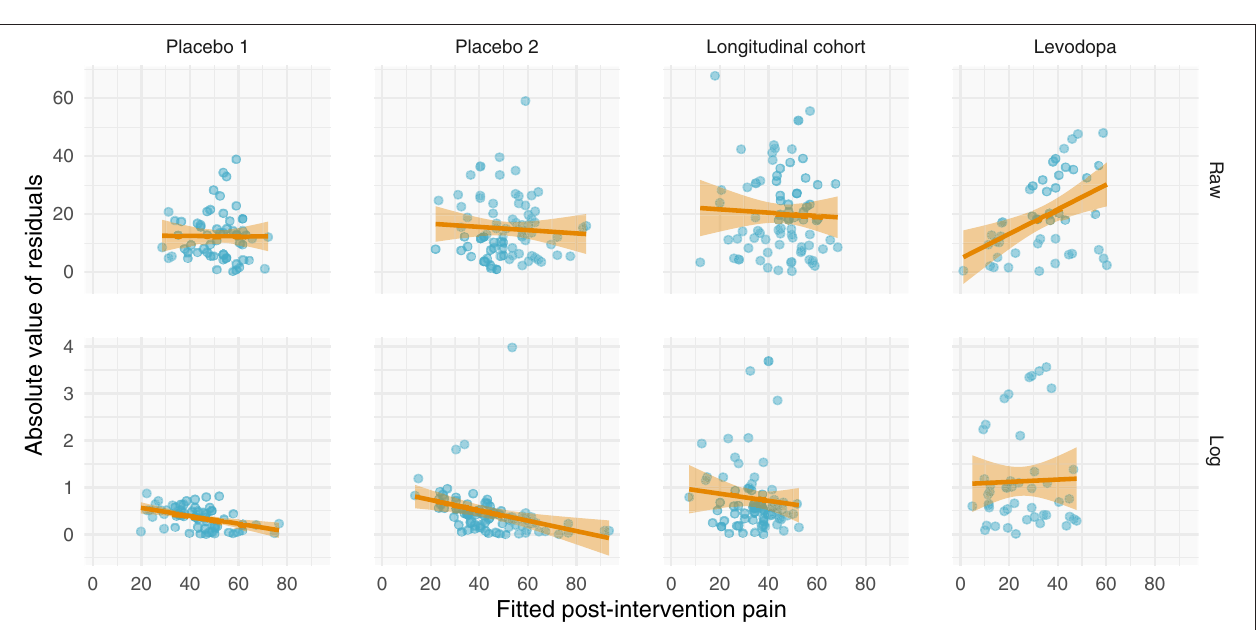
FIGURE 7 | Absolute values of residuals from additive ANCOVA models. We fit an ANCOVA to each dataset using pre-intervention score and group membership as covariates. From these models, we plotted the absolute values of the residuals as a function of the fitted value. Additive models should be homoscedastic, meaning the magnitudes of the residuals do not change as a function of the response variable. However, multiplicative models have compounding error, such that if you fit them using an additive model, greater predicted values will be associated with larger magnitudes of residual error. Placebo I, Placebo II, and the Prospective Cohort study all exhibit features of additive data. However, the Levodopa Trial exhibits multiplicative properties, as evidenced by the increasing error residual magnitude with increasing fitted